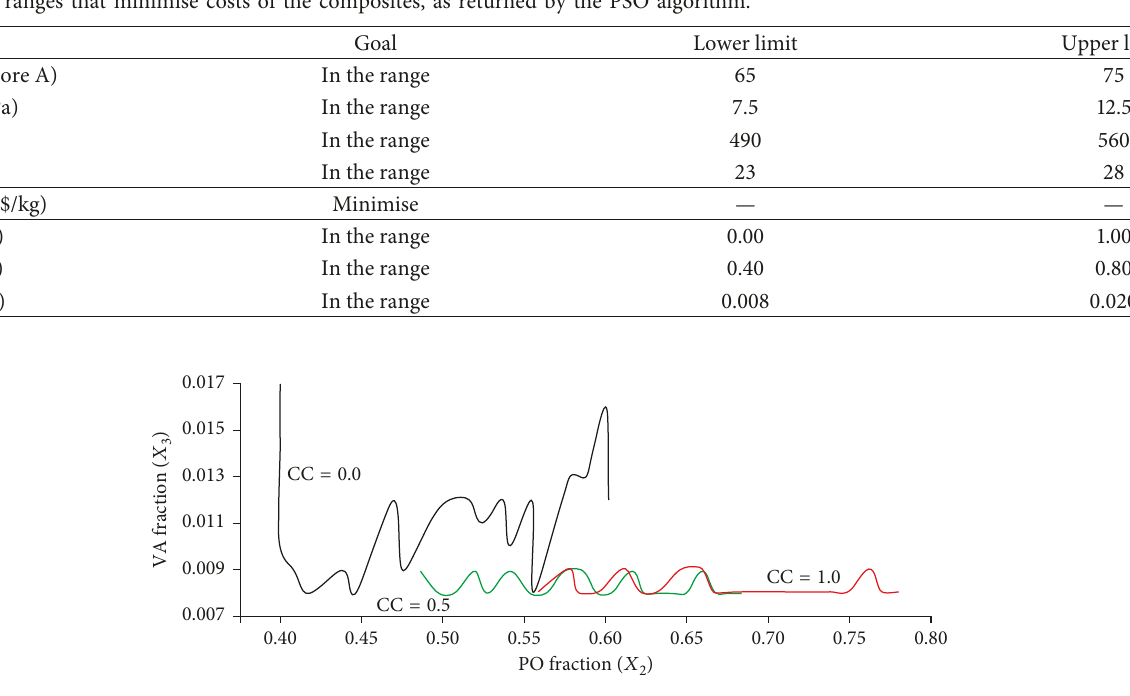
Table 6: Composition (weight fraction) of the check-point mixtures F values of hardness (HD), tensile strength (TS), elongation at break (EB), and rebound resilience (RS). Wt.